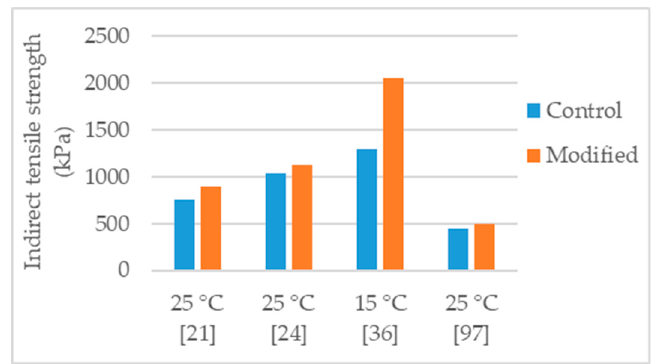
Figure 3. Indirect tensile strength of control and nanosilica modified asphalt mixtures.